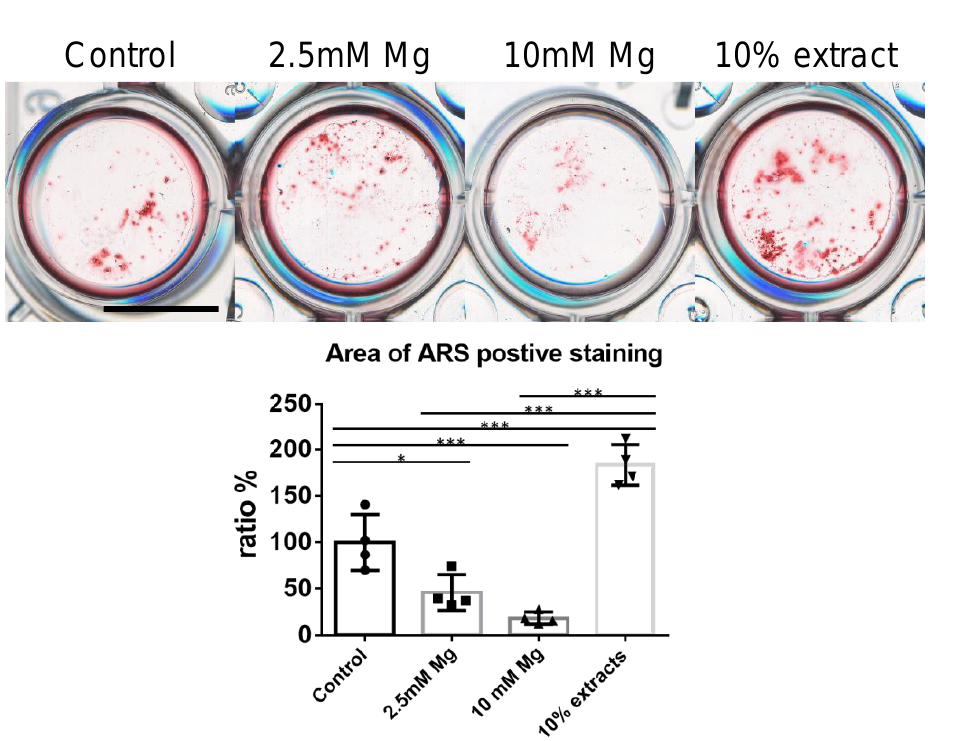
Figure 4. In vitro osteogenesis induction cultured with control medium, 2.5 mM Mg 2+ , 10 mM Mg 2+ , 10% of alloy extracts, scale bar: 10 mm, n = 4, one-way ANOVA, Tukey test, * p < 0.05, *** p < 0.001.